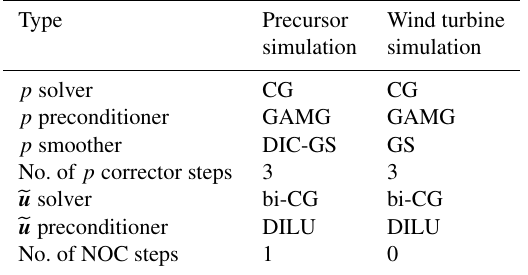
Table 1. Linear algebraic solvers used for the precursor and the wind turbine–wake simulations (CG: conjugate gradient; GAMG: geometric–algebraic multigrid; DIC: diagonal incomplete Cholesky; GS: Gauss–Seidel; DILU: diagonal incomplete LU